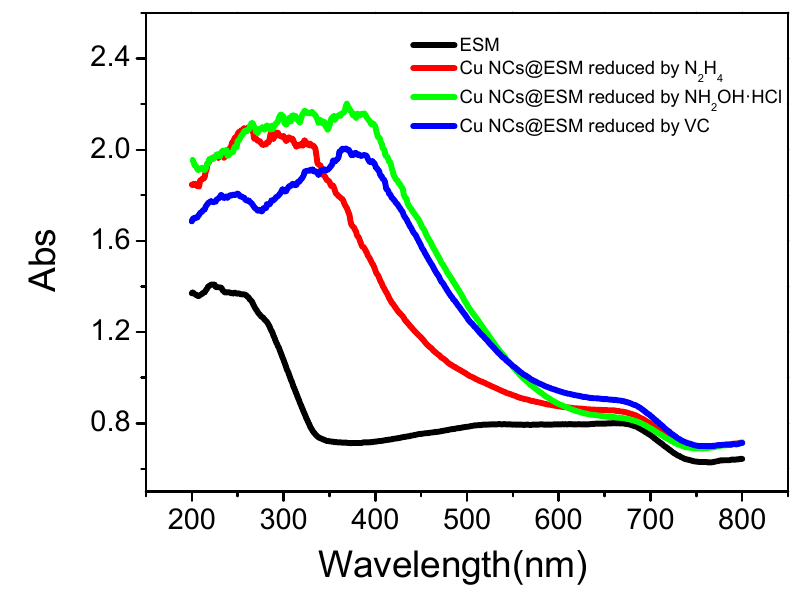
Figure 4. The UV-vis DRS spectra of natural ESM (black line) and as-obtained Cu NCs@ESM nanocomposites in situ generated by N 2 H 4 · H 2 O reduction (red line), NH 2 OH · HCl reduction (green line) and VC reduction (blue line), respectively.